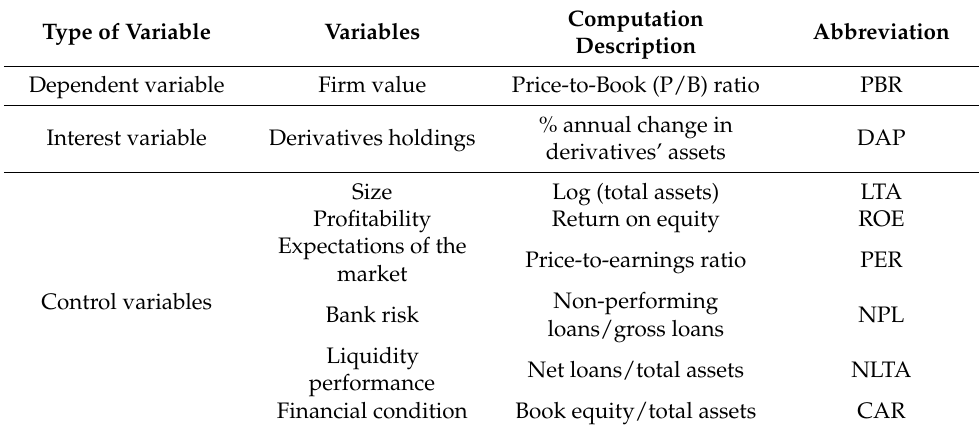
Table 2. Variables used in the